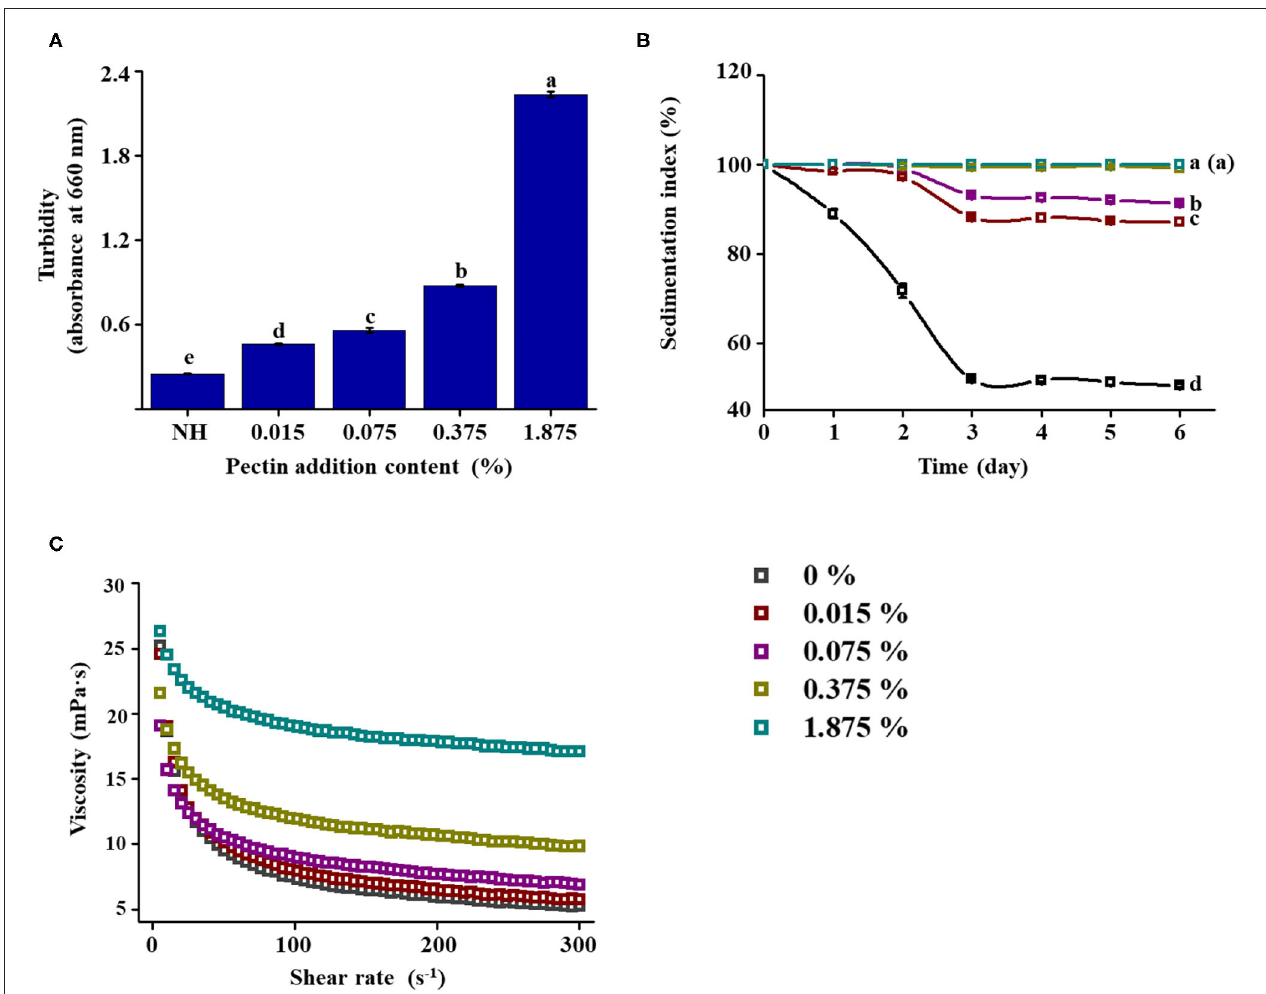
FIGURE 7 | Effect of addition of pectin (after HPH) at various concentrations on the stability of NFC orange juice. (A) Turbidity; (B) Sedimentation index; (C) Viscosity curves.